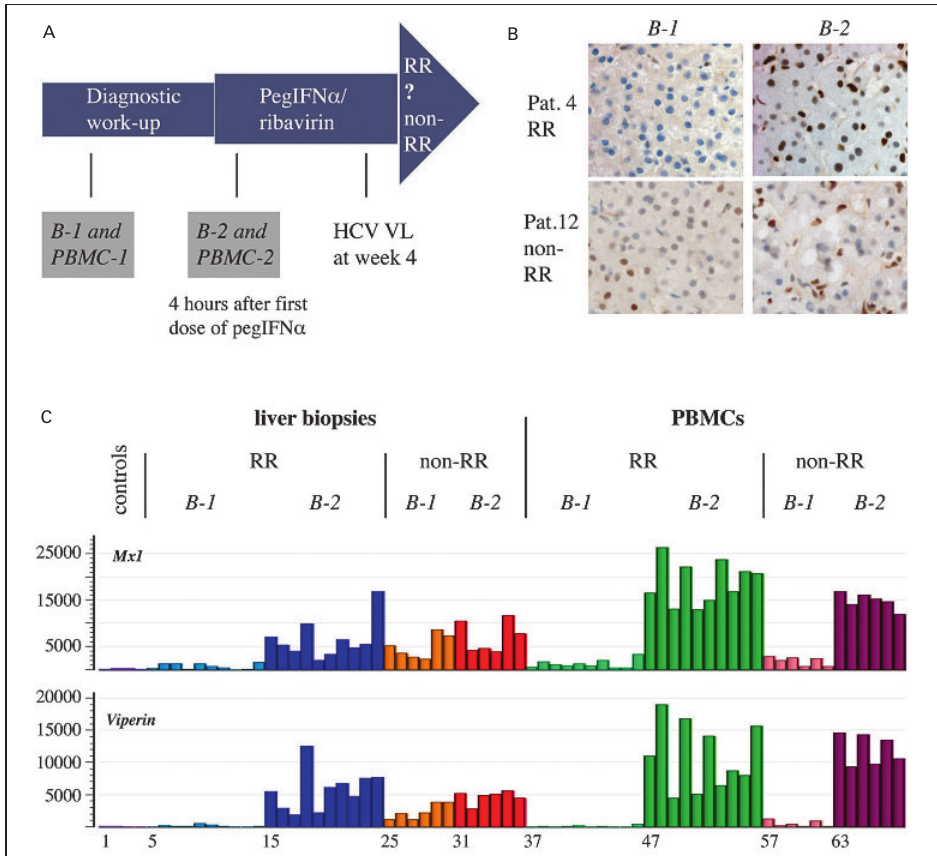
IFN signalling and treatment outcomes in chronic hepatitis C. A. An initial liver biopsy (B-1) and an initial PBMC sample (PBMC-1) were obtained during diagnostic examination of patients with CHC.The second biopsy (B-2) and a second sample of PBMCs (PBMC-2) were collected 4 hours after the first dose of pegIFN α . After 4 weeks of pegIFN α and ribavirin combination therapy, patients were defined as rapid responders (RRs) or non-RRs depending on the drop in HCV viral load (VL). B. We performed immunohistochemical staining of the activated transcription factor STAT1 in liver biopsy samples. Shown are representative examples of B-1 and B-2 of RR and non-RR patients. No nuclear staining is evident in pre-treatment biopsies of RR patients (Patient 4).The light blue colour of the nuclei originates from the counterstaining with hematoxylin. Four hours after pegIFN α , most hepatocytes show strong nuclear staining (in brown). In non-RR patients (Patient 12), weak nuclear staining is already present in pre-treatment biopsies, and pegIFN α induces little change in hepatocytes.The visible increased nuclear staining is confined to Kupffer cells. C. Gene expression pattern of two classical ISG mRNAs (Mx1 and Viperin). Expression in B-1 samples of RR patients (lanes 5–14) resembles healthy control tissue (lanes 1–4), whereas ISG levels in B-1 samples of non-RRs (25–30) are elevated. PegIFN α treatment increases the ISG mRNA level in B-2 samples in the RR (15–24), but not the non-RR (31–36) patient group. PBMC-1 and -2 samples do not differ substantially between RRs (37–56) and non-RRs (57–68). (Reprinted with permission from Sarasin-Filipowicz et al., Proc Natl Acad Sci U S A 2008;105:7034–9. Copyright 1993–2008 by the National Academy of Sciences, Washington,